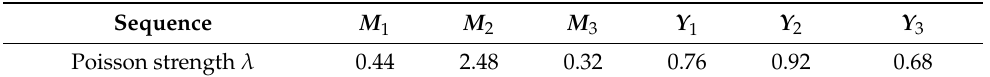
Table 7. Poisson intensity.